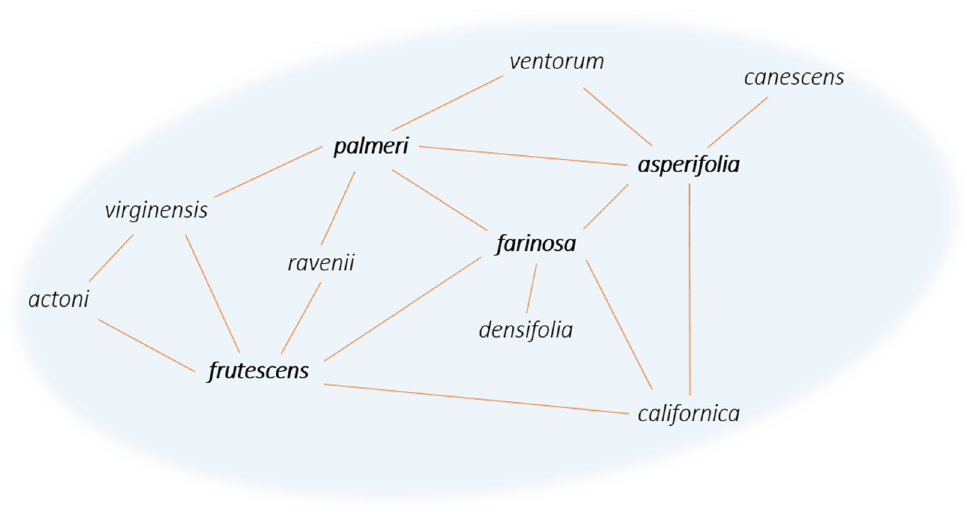
Figure 5. Network diagram of the Encelia syngameon (adapted from [92]). Lines connecting species represent gene flow, with species such as E. frutescens , E. farinosa , E. palmeri, and E. asperifolia exemplifying hubs of introgression (in bold).